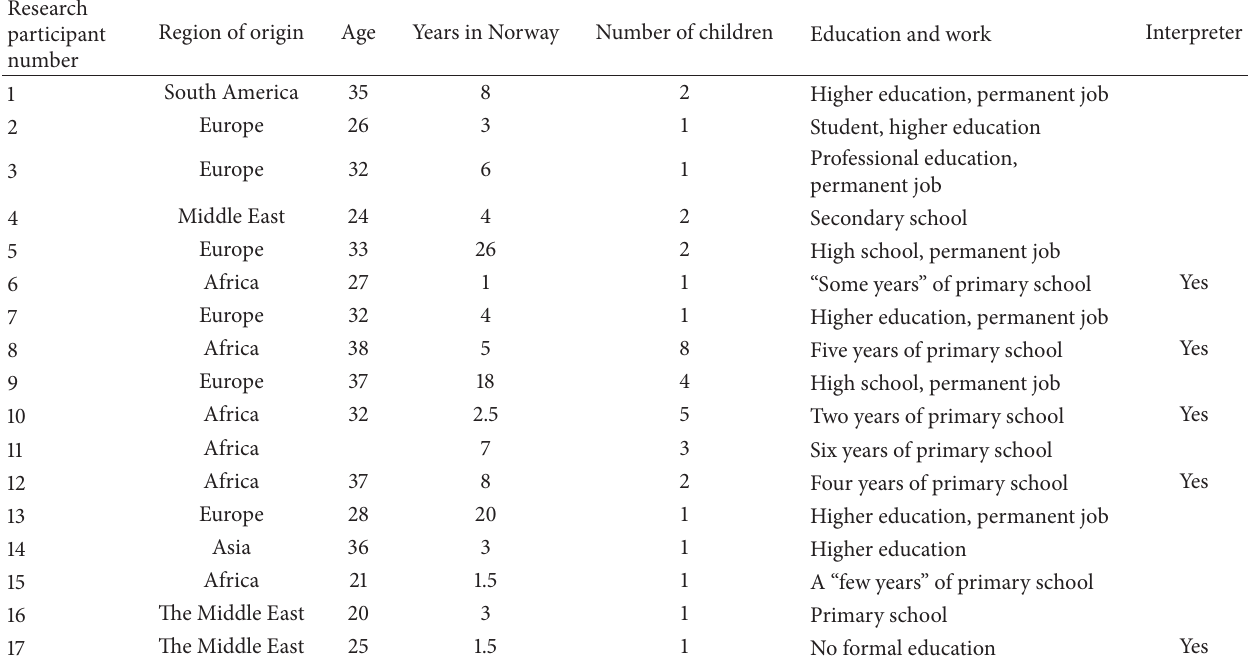
Table 1: Research participants, region of origin, age, number of years in Norway, education and work, number of children, and use of